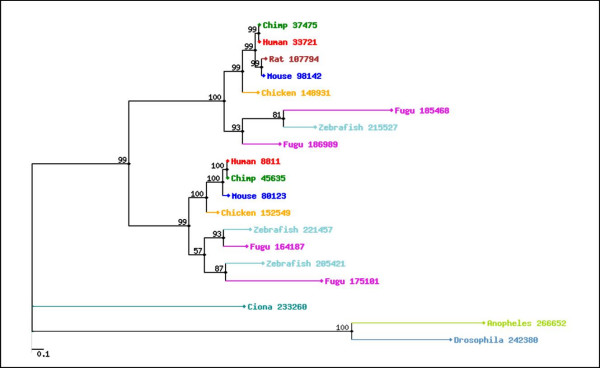
An example phylogenetic tree. This is one output of the PhIGs analysis that is shown on the Cluster View webpage. Instead of simply listing the members of a cluster, a phylogenetic tree is created showing the evolutionary relationships of this multigene family. In this example, we can see that this family had gene duplication events at the base of vertebrates and in the fish lineage. Because the branch lengths are proportional to the rate of amino acid substitutions, we can see how rates of evolution have varied.